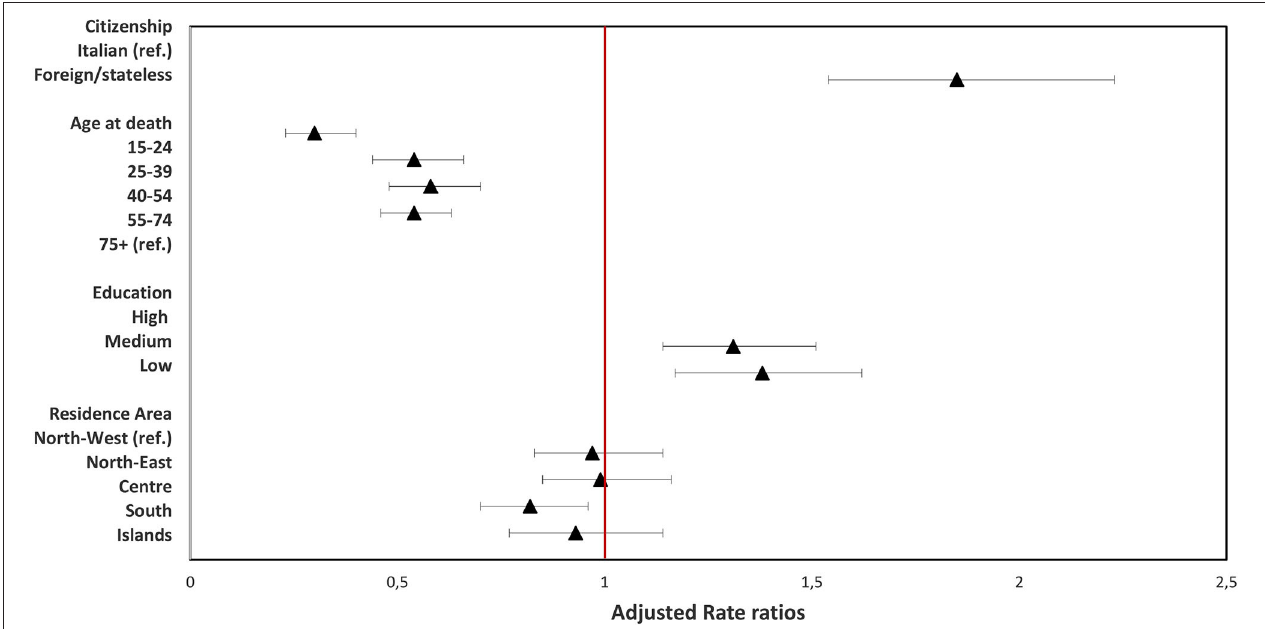
FIGURE 1 | Results of multivariate quasi-Poisson regression model (Females).